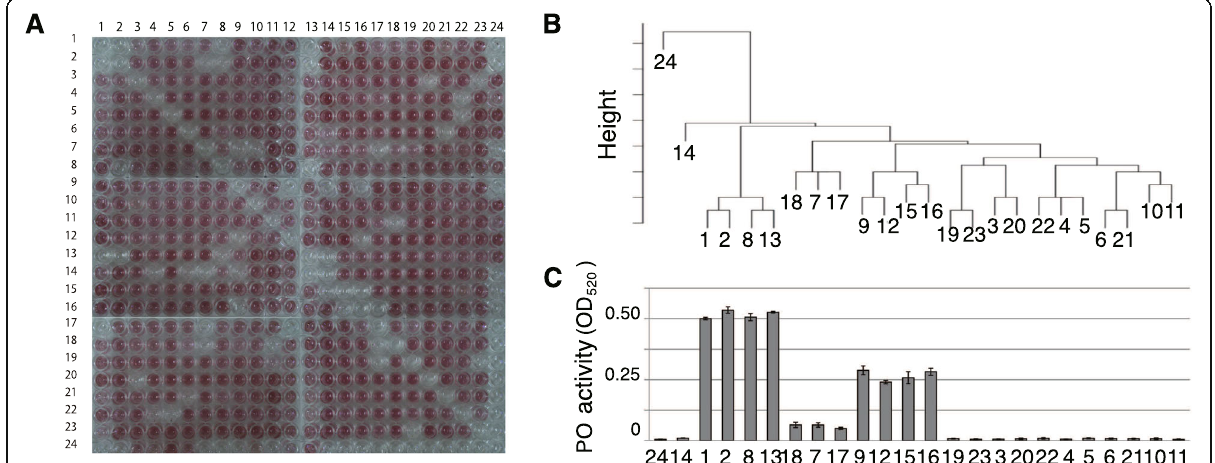
Fig. 4 mAb11B16B10-induced PO activity and CR-induced PO activity in 24 individuals. a CR-induced colorimetric PO activity assays of hemocytes from 24 individuals. b Hierarchical clustering of the activities shown in a and Additional file 6: Table S1. c mAb11B16B10-induced OD 520 values from Fig. 2B ( n =